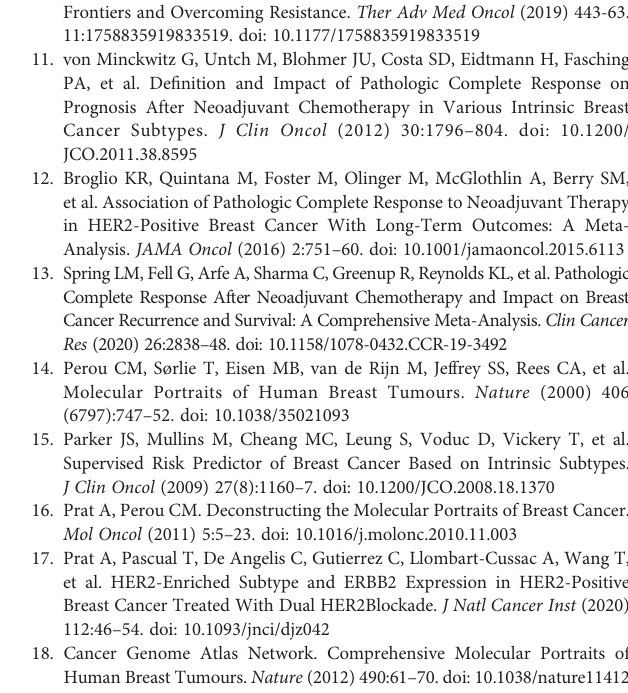
Supplementary Table 2 | Characteristics of the studies included. Supplementary Figure 1 | Risk-of-bias review of each included study. Supplementary Figure 2 | Forest plots of sensitivity and speci fi city. 2A. Sensitivity. 2B. Speci fi city. Supplementary Figure 3 | Funnel plot of publication